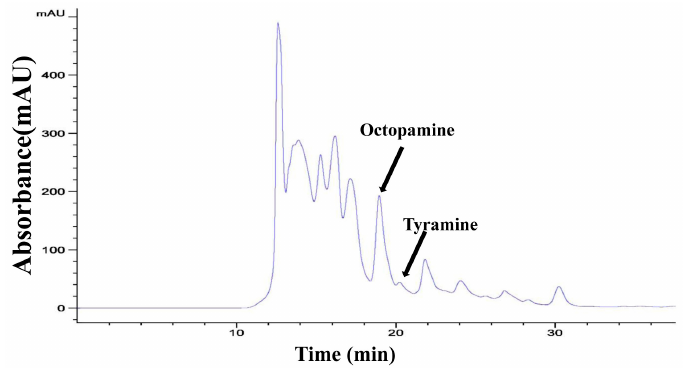
Figure 4. The prominent peak retention time of samples by HPLC with a C30 column. The black arrows are octopamine and tyramine.